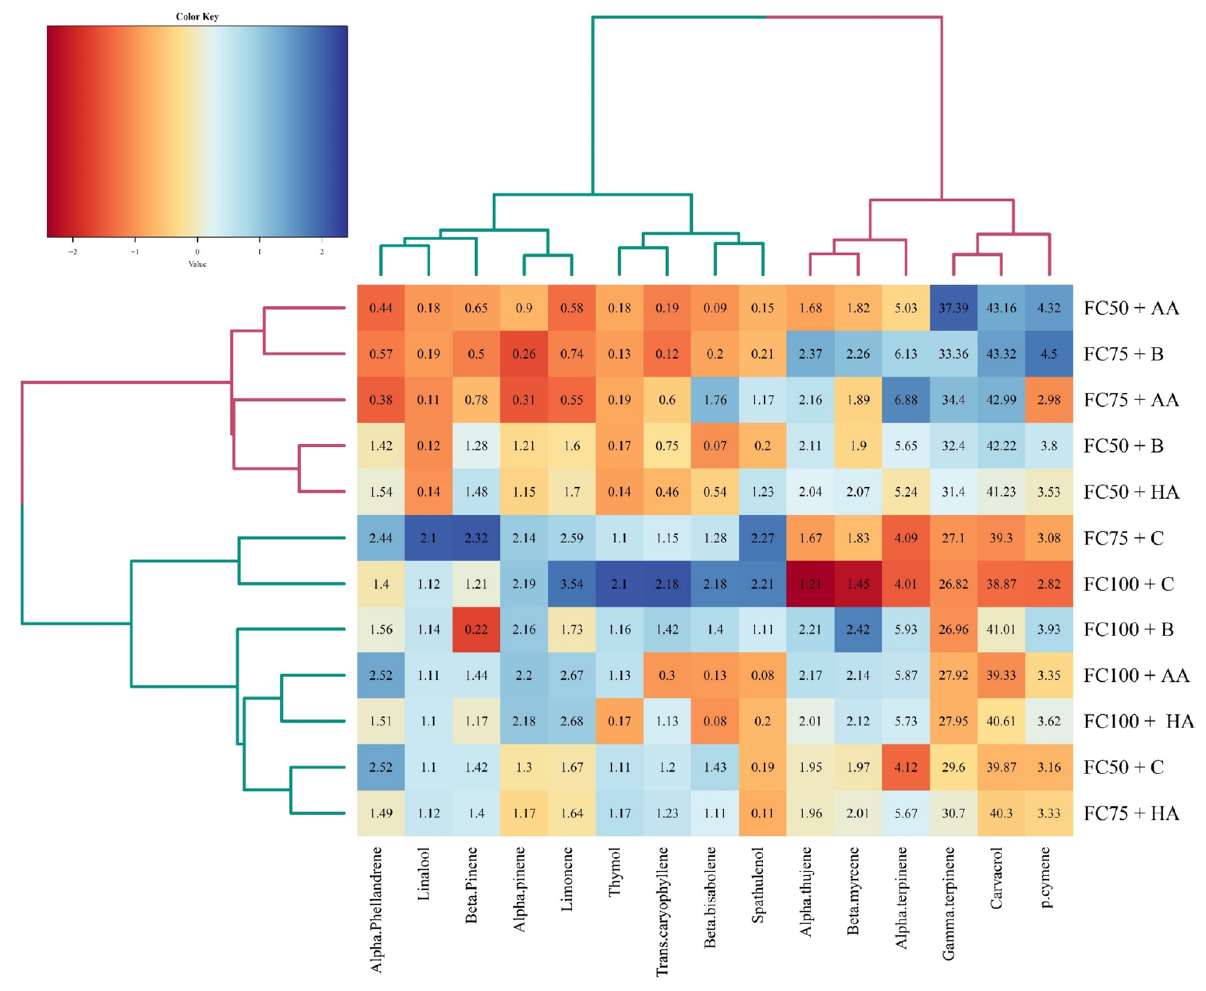
Figure 6. Heatmap clustering of irrigation regime (FC100, 100% field capacity; FC75, 75% field capacity; FC50, 50% field capacity) and fertilizer application ( C control, HA humic acid, B bacterial, AA amino acid) sources based on essential oil constituents in in summer savory ( Satureja hortensis L.). The key color bar indicates standardized mean values (dark red indicates relatively low mean values; dark blue indicates relatively high mean